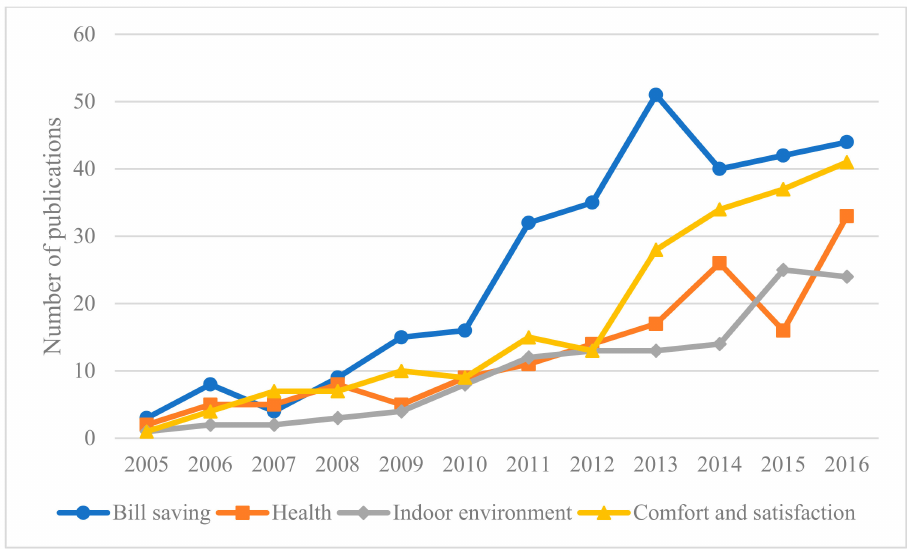
Figure 2. Process of the research design.